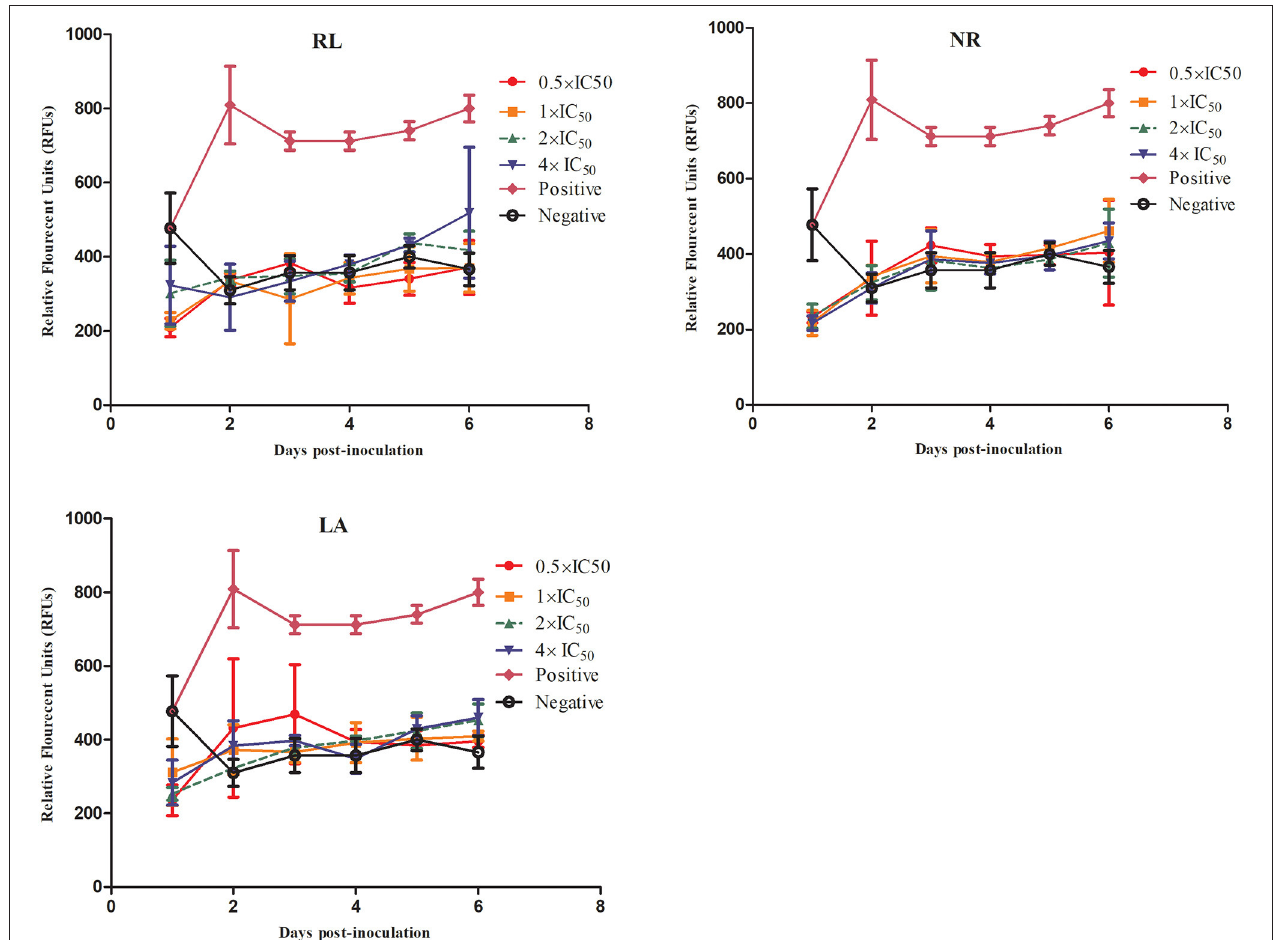
FIGURE 3 | Viability test of RL, NR, and